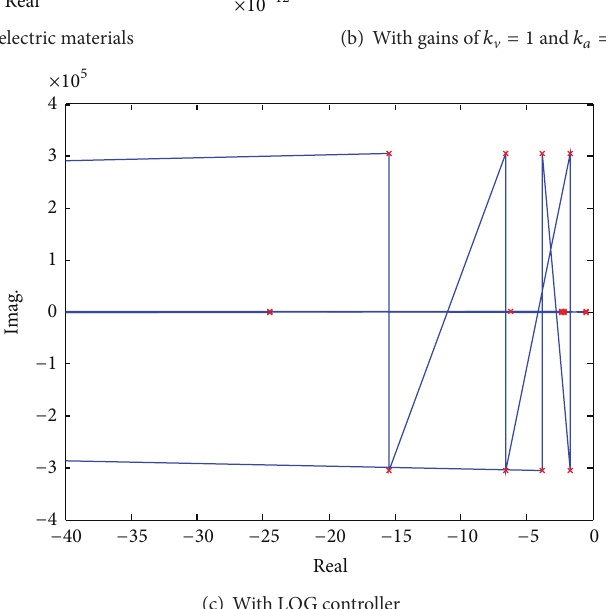
Figure 3: Imag.-Real plot of homogeneous equation system for 𝑈 = 34.69 m/s defined in